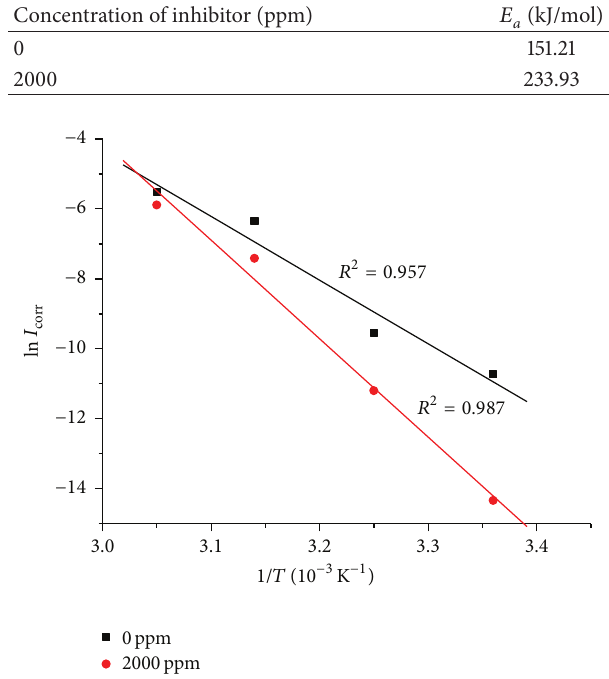
Figure3:Arrheniusplotsof304SSin0.5MH 2 SO 4 withoutandwith inhibitor addition.